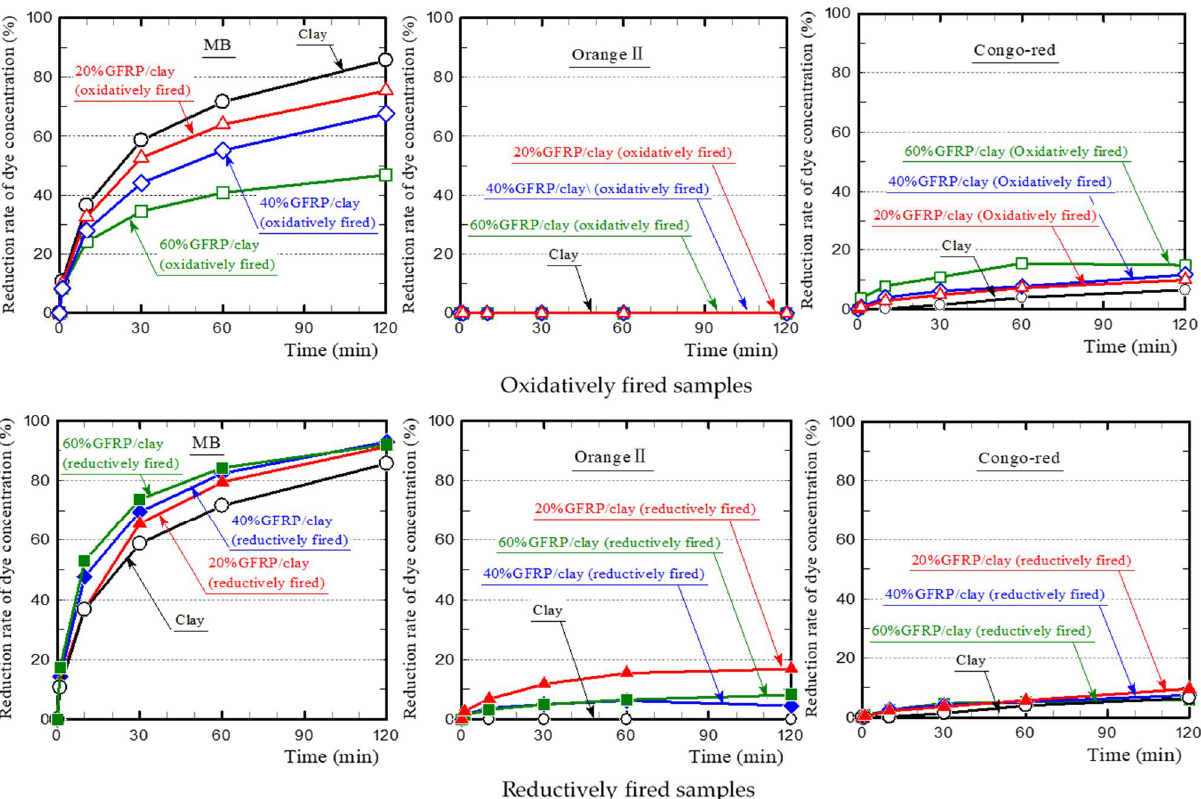
Figure 7. Dye concentration reduction rates of samples.